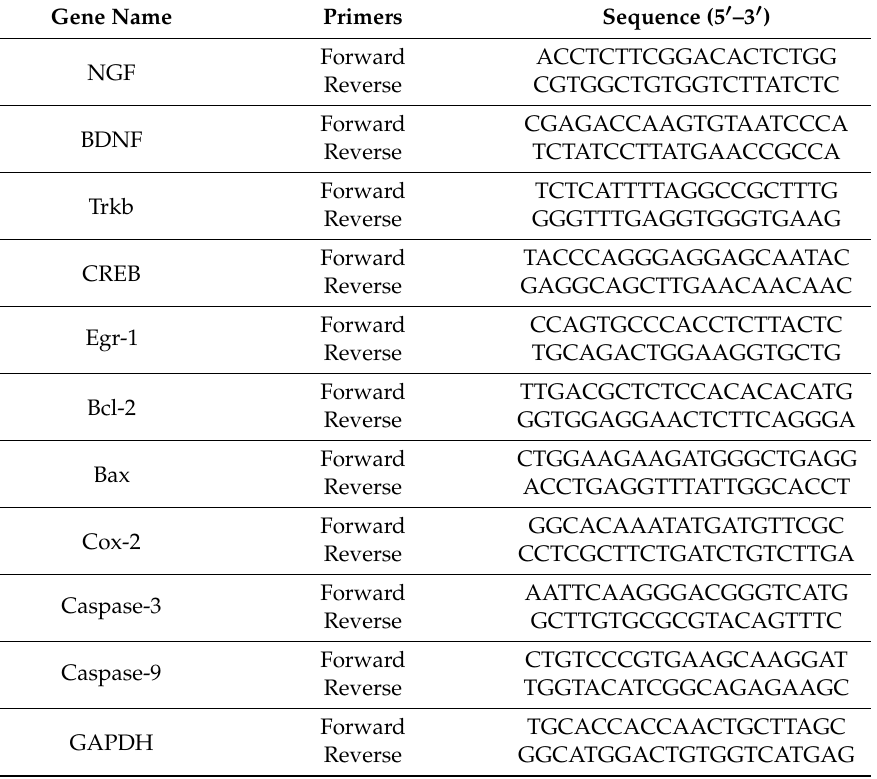
Table 1. Primer sequence used in the animal